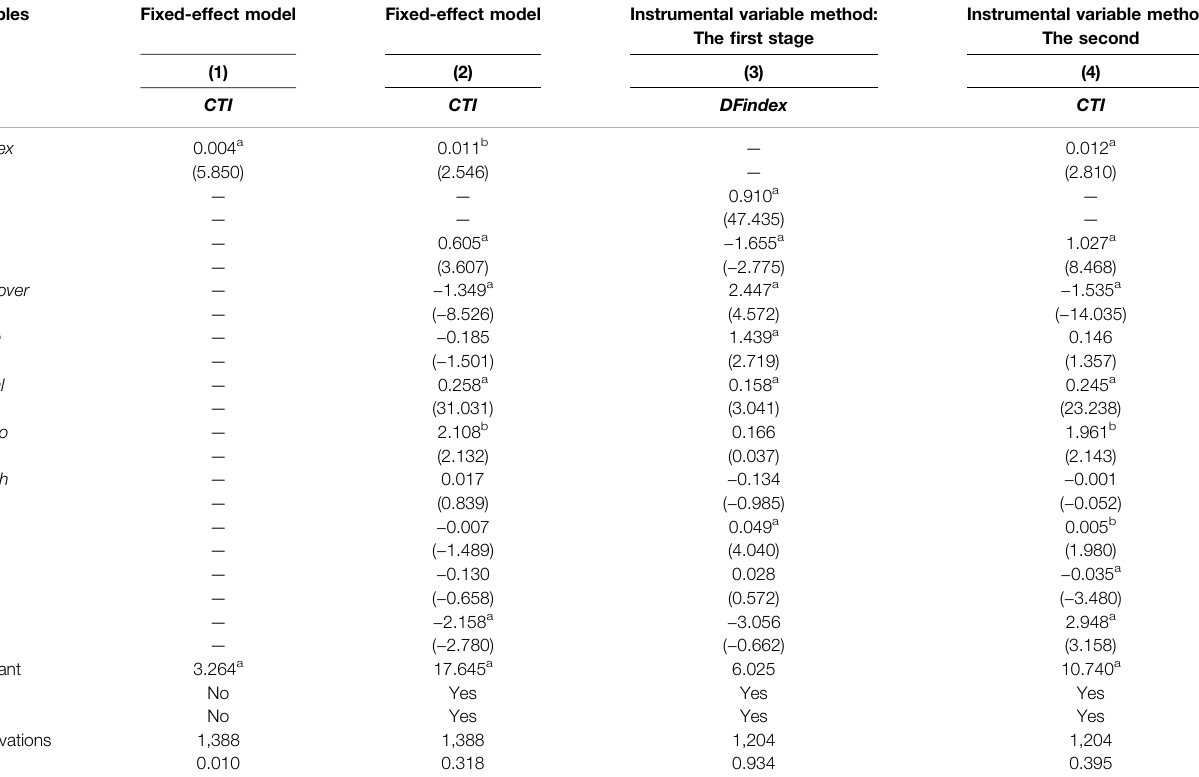
TABLE 3 | Estimation of the impact of digital fi nance development on the continuous technological innovation of Chinses energy